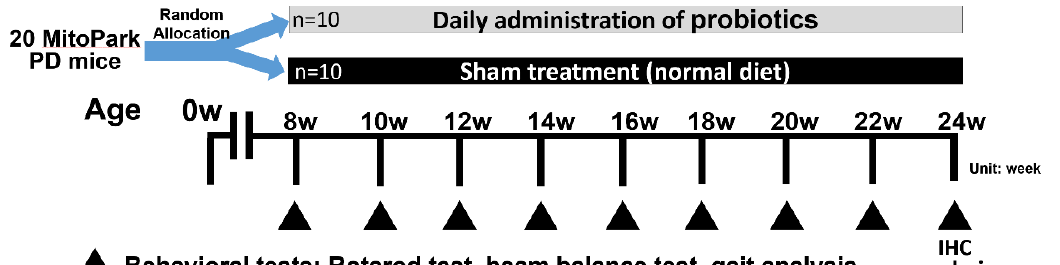
Figure 1. Experimental design for the identification of long-term effects of probiotic administration in MitoPark Parkinson’s disease (PD) mice ( n = 20). Daily administration of probiotics was treated from